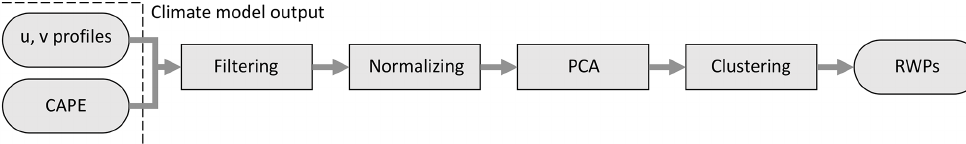
Figure 1. Schematic of clustering procedure. The four processing steps are shown as rectangles and the input and output as rounded rectan- gles.